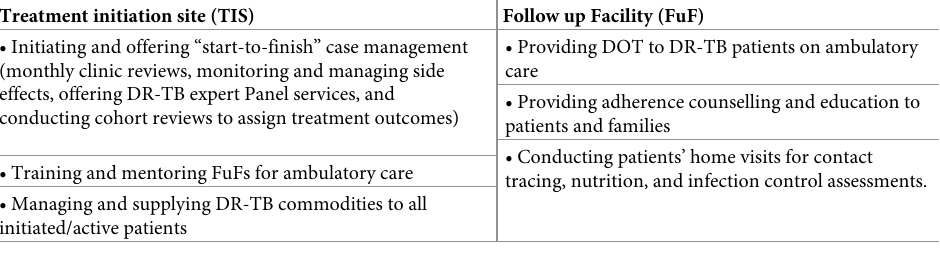
Table 1. Roles of treatment initiation sites and FuFs in DR-TB